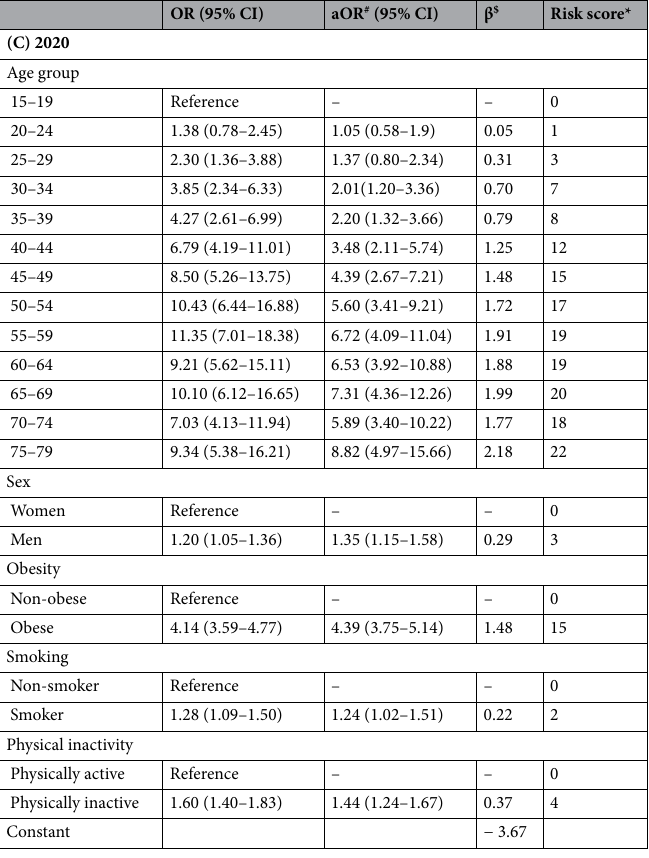
Table 1. Multivariable logistic regression of risk factors for diabetes mellitus at three different time points: (A) 2020, (B) 2030, and (C) 2050. The regression was used to derive the Qatari diabetes risk score. # Odds ratios adjusted for age, sex, obesity, smoking, and physical inactivity. $ β-coefficients based on multivariable analysis. *The maximum specific risk score for any given risk factor is 26 for 2020, 24 for 2030, and 22 for 2050. ¥ Defined as body mass index ≥ 30 kg/m 220 . # Defined as those currently smoking tobacco daily 20 . € Defined as < 150 min of moderate activity and < 75 min of vigorous activity per week (i.e., < 600 metabolic equivalent- minutes per week) 20